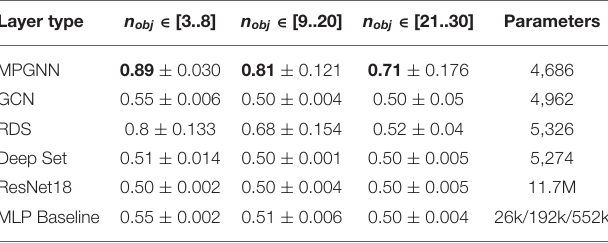
TABLE 2 | Test classification accuracies for the three different models on the discrimination task. Layer